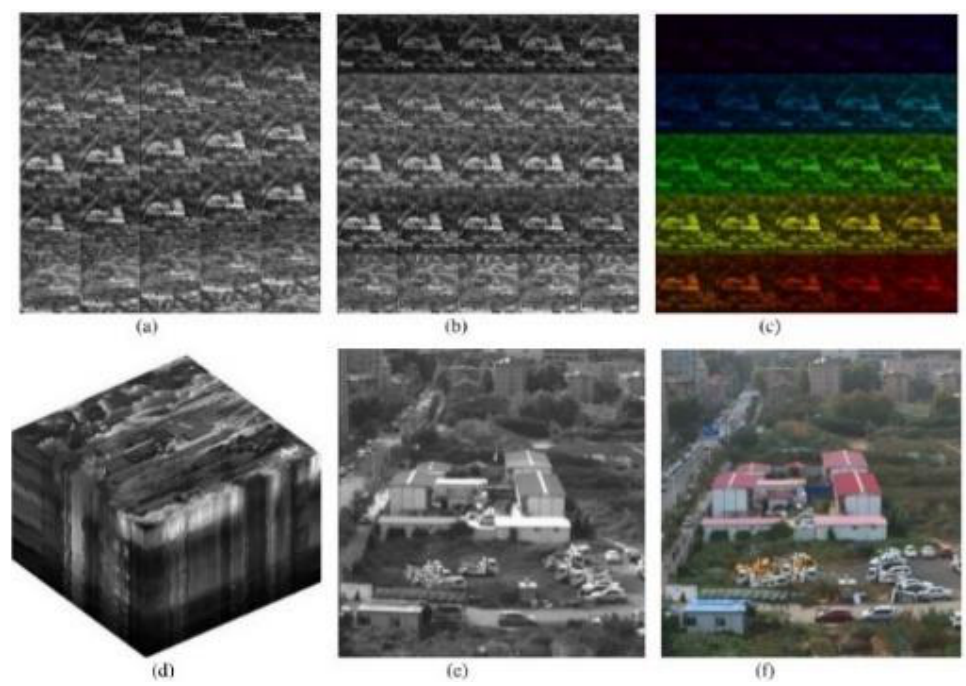
Figure 39. Image results of a static scene. ( a ) Original, shifted, gray sub-images; ( b ) remapped spectral images; ( c ) remapped spectral images with color fusion; ( d ) the 3D data cube; ( e ) a single, gray sub-image; ( f ) an RGB image of a similar scene captured using a cell phone.